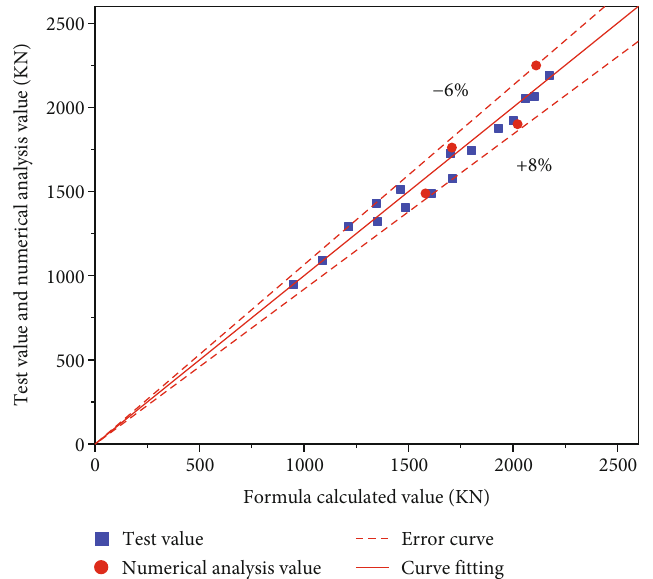
Figure 13: Comparison of the bearing capacity calculated by the formula with the experimental or simulated bearing